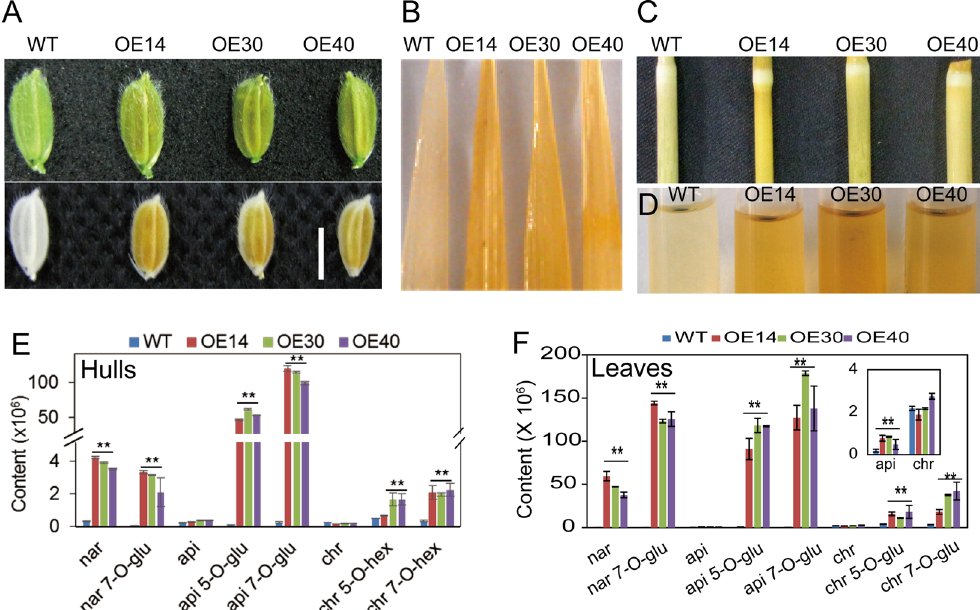
Figure 2. Overexpression of SQD2.2 enhanced flavonoid accumulation in various tissues. ( A ) to ( D ) Flavonoid in hulls ( A ), leaves ( B ) and stems ( C ) and methanol extracts from leaves ( D ). Plants were grown in a paddy field under normal growth conditions, and the samples were photographed after chlorophyll was removed by ethanol. ( E ) and ( F ) Overexpression of SQD2.2 increased flavonoid levels, with the predominant accumulation of 7-O-glycosidic and 5-O-glycosidic flavonoids in seed hulls ( E ) and leaves ( F ). nar, naringenin; nar 7-O-glu, naringenin 7-O-glucoside; api, apigenin; api 5-O-glu, apigenin 5-O-glucoside; api 7-O-glu, apigenin 7-O-glucoside; chr, chrysoeriol; chr 5-O-hex, chrysoeriol 5-O-hexoside; chr 7-O-hex, chrysoeriol 7-O-hexoside. Values are the mean ± SD (n = 6). Student’s t test; ** P < 0.01. Scale bar = 0.5